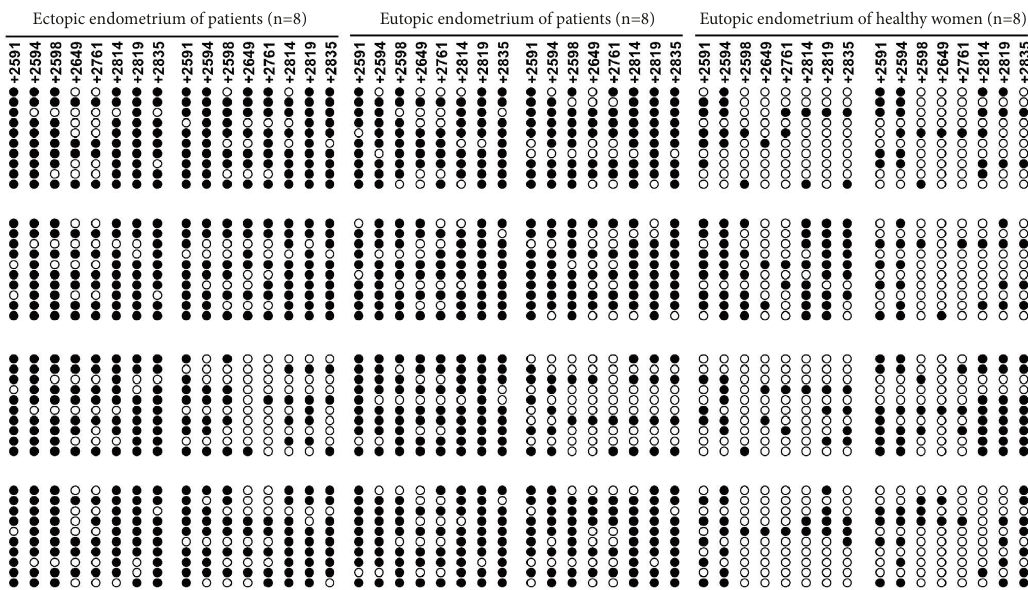
Figure 4: Te deoxyribonucleic acid methylation status of human leukocyte antigen-C (HLA-C) ∗ 07 introns VII. Te open and flled circles represent unmethylated and methylated cytosines, respectively. Te numbers on top indicate the positions of cytosine residues of 5 ′ –C–phosphate–G–3 ′ relative to the transcriptional start site (+1). A total of 16 HLA-C ∗ 07-carrier individuals were enrolled: eight patients with endometriosis and eight healthy women. Both the eutopic and ectopic endometria of the patients were women. Of the 8 HLA-C ∗ 07 endometriosis patients, 87.5%